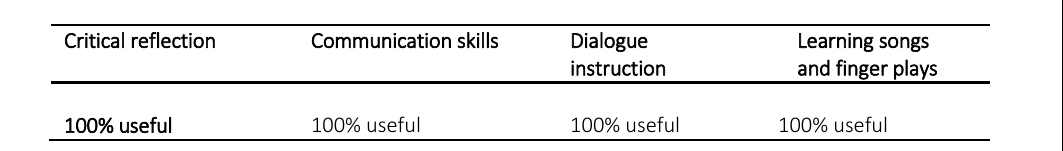
Table 2: Efficacy of the targeted workshops Critical reflection Communication skills